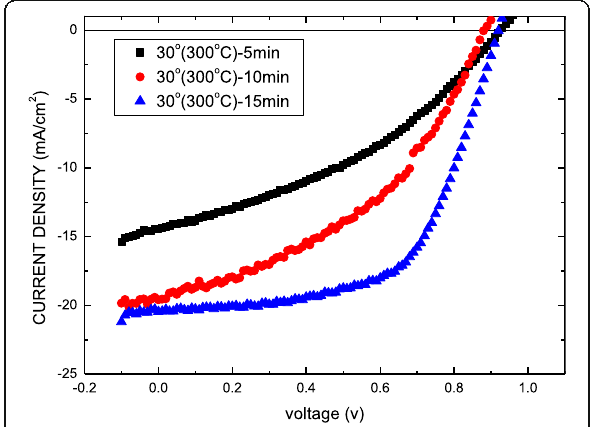
Fig. 8 Current density – voltage ( J – V ) of solar cells based on MAPbI 3 perovskite with oblique ITO layer sputtered for various sputtering